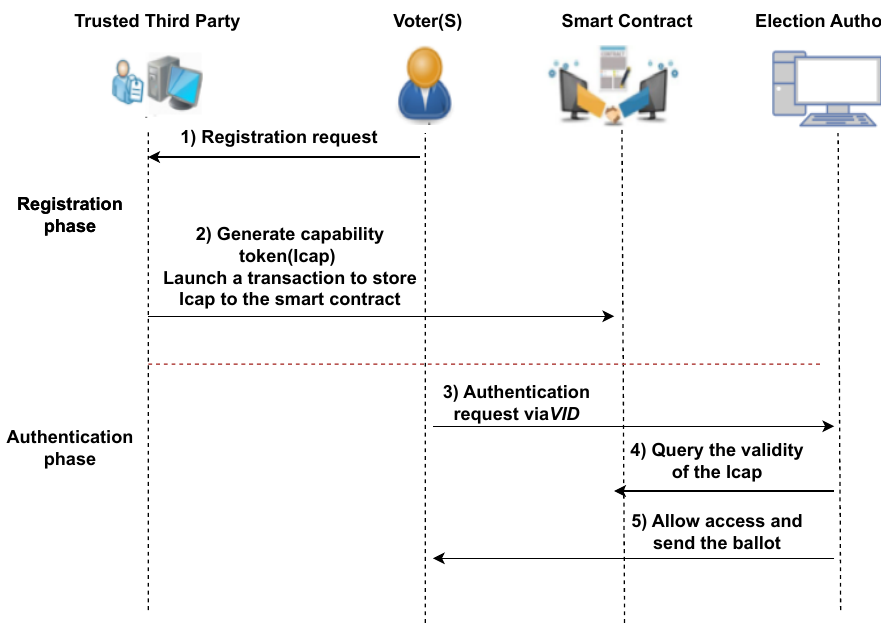
Figure 2. Voter-access control is carried out using two phases: the registration phase and the au- thentication phase. Effective access-control processes for voting services and information in e-voting systems is achieved by PVPBC by offering an anonymous authentication mechanism where the voter’s vote can be revoked by the election service provider with the cooperation of a trusted